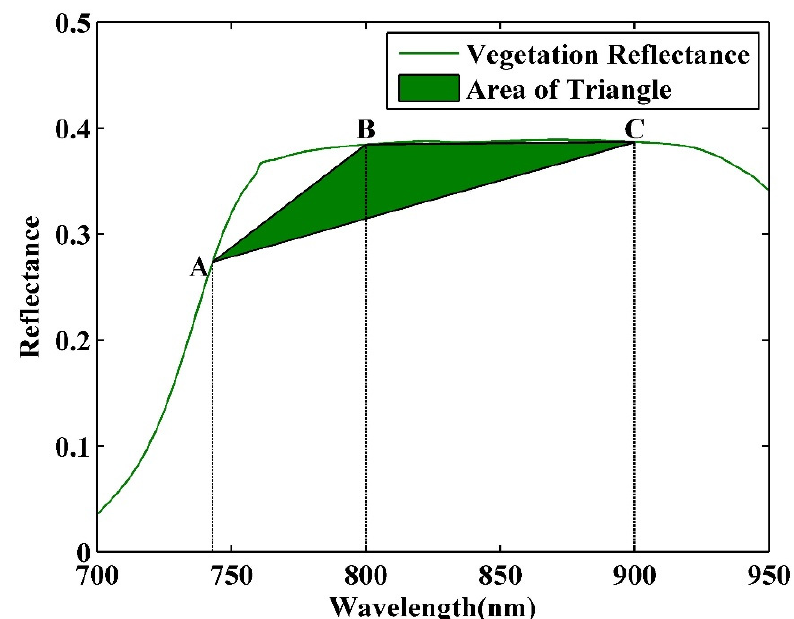
Figure 5. The triangular area of the transformed triangular vegetation index 2 (TTVI2). The vegetation reflectance comes from the No. 9 sampling plot at the head emergence stage.